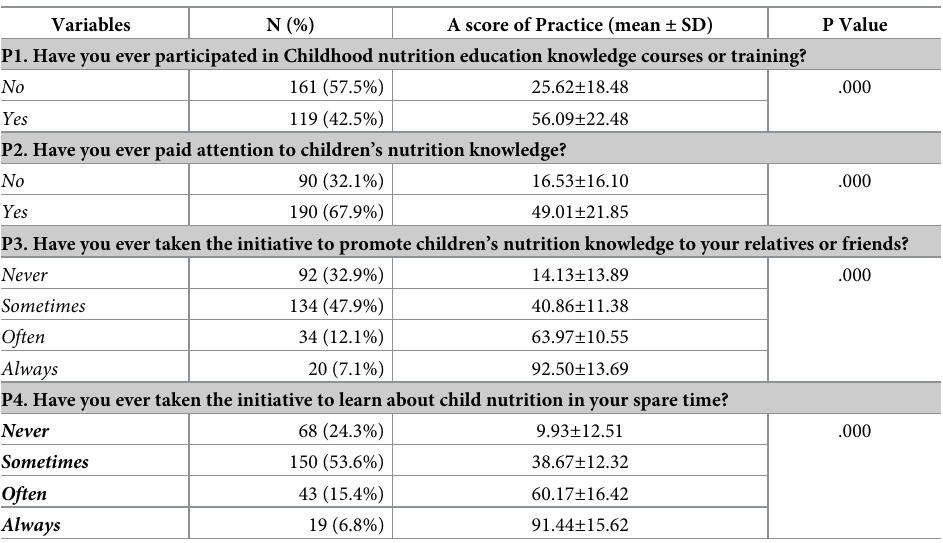
Table 4. The average score of each dimension in nutrition-related practices.